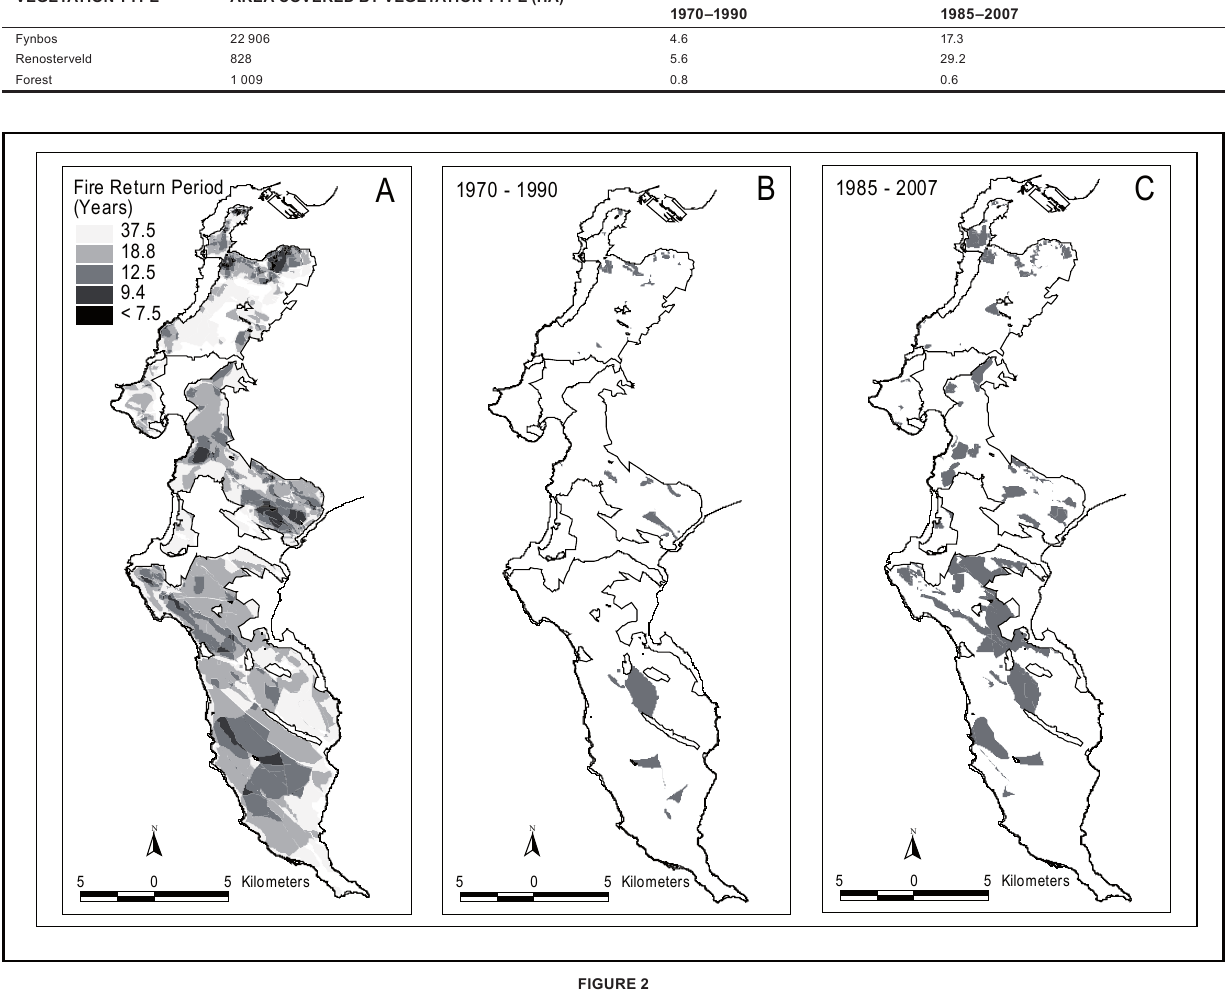
Figure 2 Fire return periods in the Table Mountain National Park. A = mean fire return periods based on all fires between 1970 and 2007. Note that unshaded areas within the park boundary did not burn (i.e. mean fire return period was > 37.5 years), while unshaded areas outside of the park boundary were not included in the analysis. B = the spatial occurrence of short (≤ six yrs) fire return periods between 1970 and 1990. C = the spatial occurrence of short (≤ six yrs) fire return periods between 1985 and